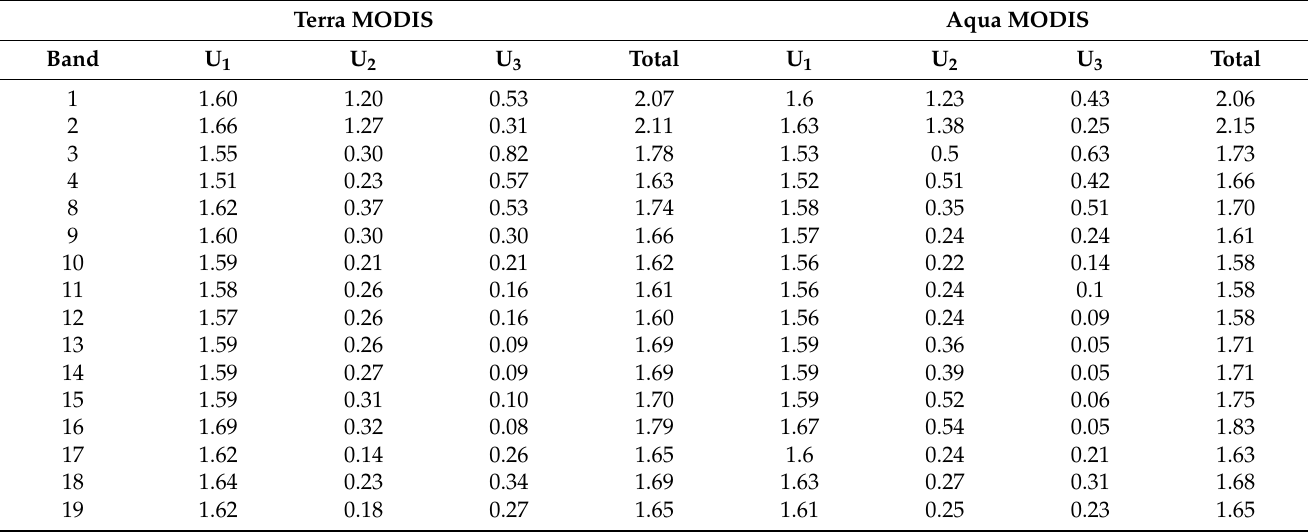
Table 6. Terra and Aqua MODIS lunar calibration uncertainty. The uncertainties are listed as a percentage. Terra MODIS